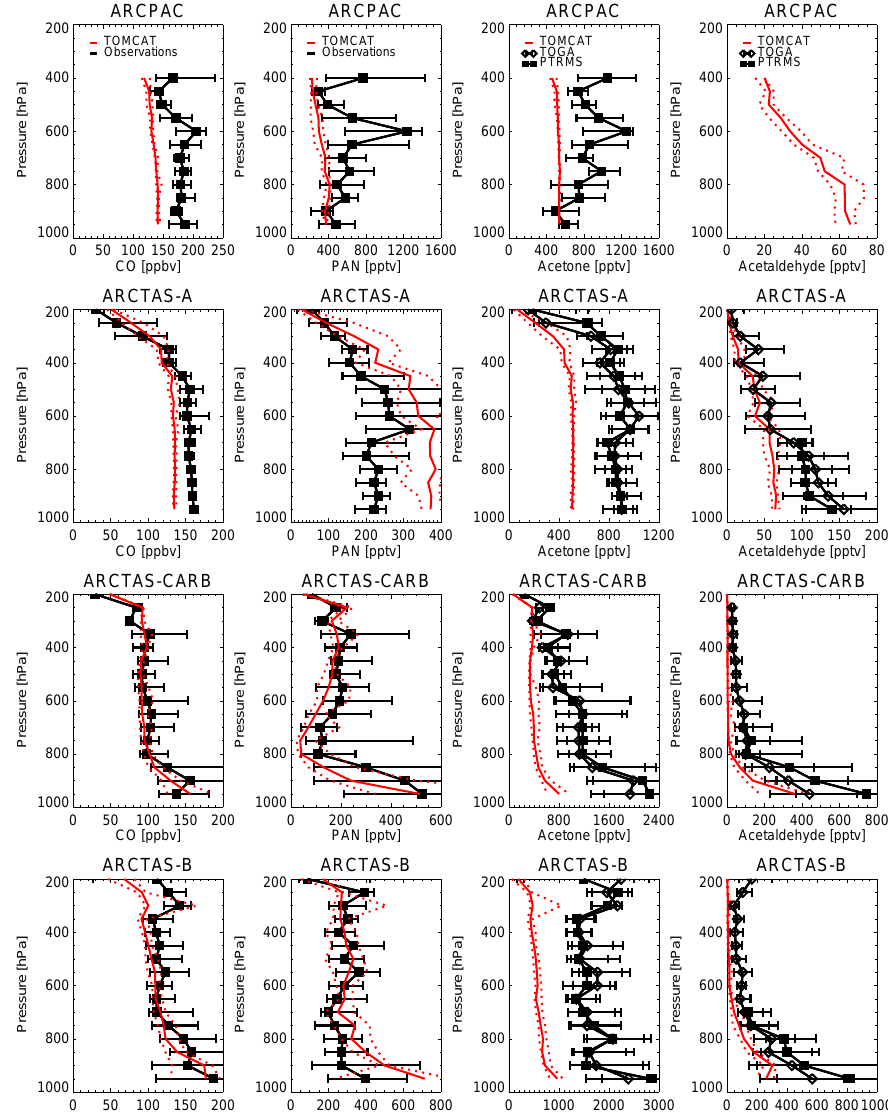
Figure 8. Observed profiles of CO (ppbv), PAN, acetone, and acetaldehyde (pptv) for 2008 from the ARCPAC and ARCTAS campaigns compared to results from the TOMCAT model sampled in the same location. The black lines give the median observed concentration and the error bars give the 25th and 75th percentiles. The solid red line gives the median modelled concentration, and the dotted lines give the 25th and 75th